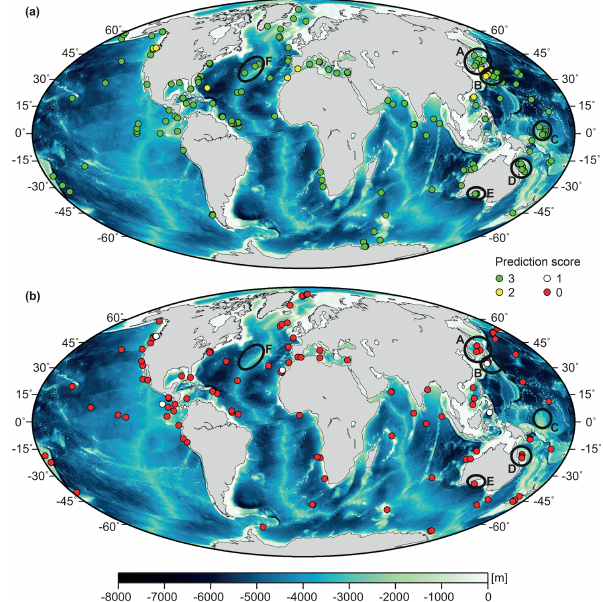
Figure 5. Distribution of boreholes with (a) good (scores 2 and 3) and (b) bad (scores 0 and 1) v p predictions. Areas A–E mark clus- ters of boreholes in the Sea of Japan (A), the Nankai Trough (B), the Ontong Java Plateau (C), the Queensland Plateau (D), and the Great Australian Bight (E). Area F indicates an example for remote boreholes of score 3 on the Mid-Atlantic Ridge. Bathymetry (30s resolution) is from the GEBCO_2014 grid